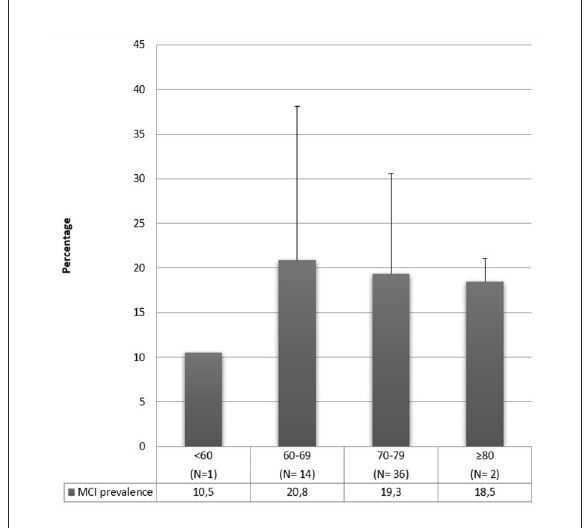
FIGURE2 MCI mean prevalence rates according to age.